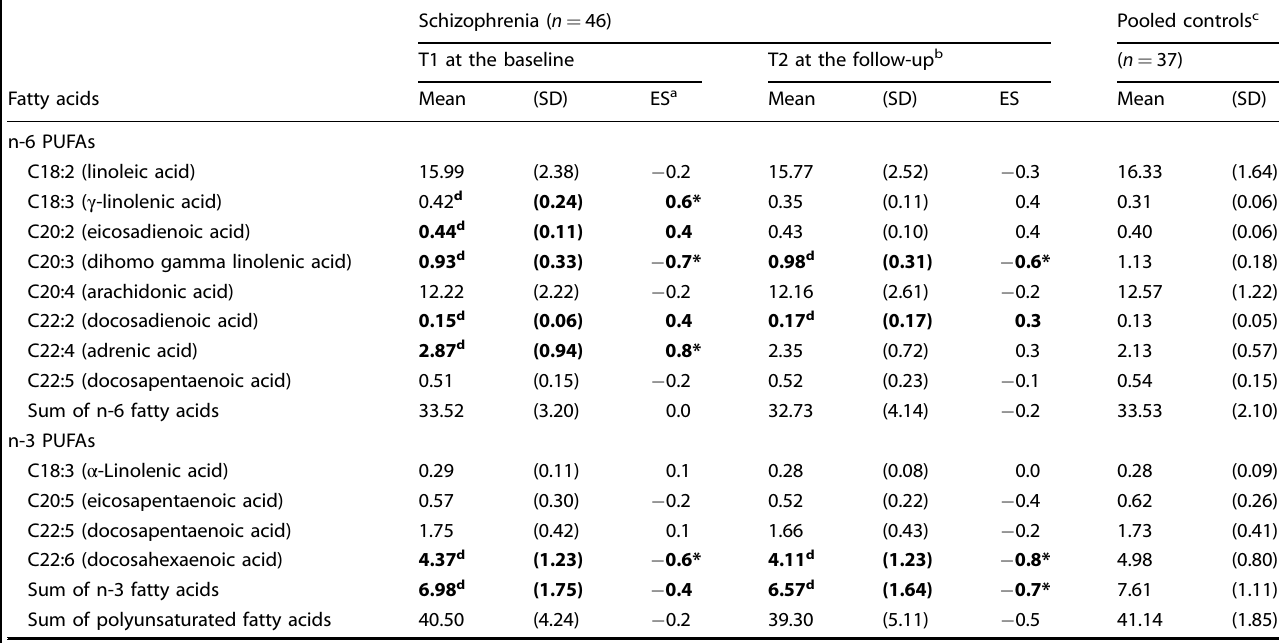
Table 2. Fatty acid composition (%) of red blood cells at the acute (T1) and partial remission stage (T2) of the schizophrenia patients as compared to the pooled controls. Schizophrenia ( n = 46) Pooled controls c T1 at the baseline T2 at the follow-up